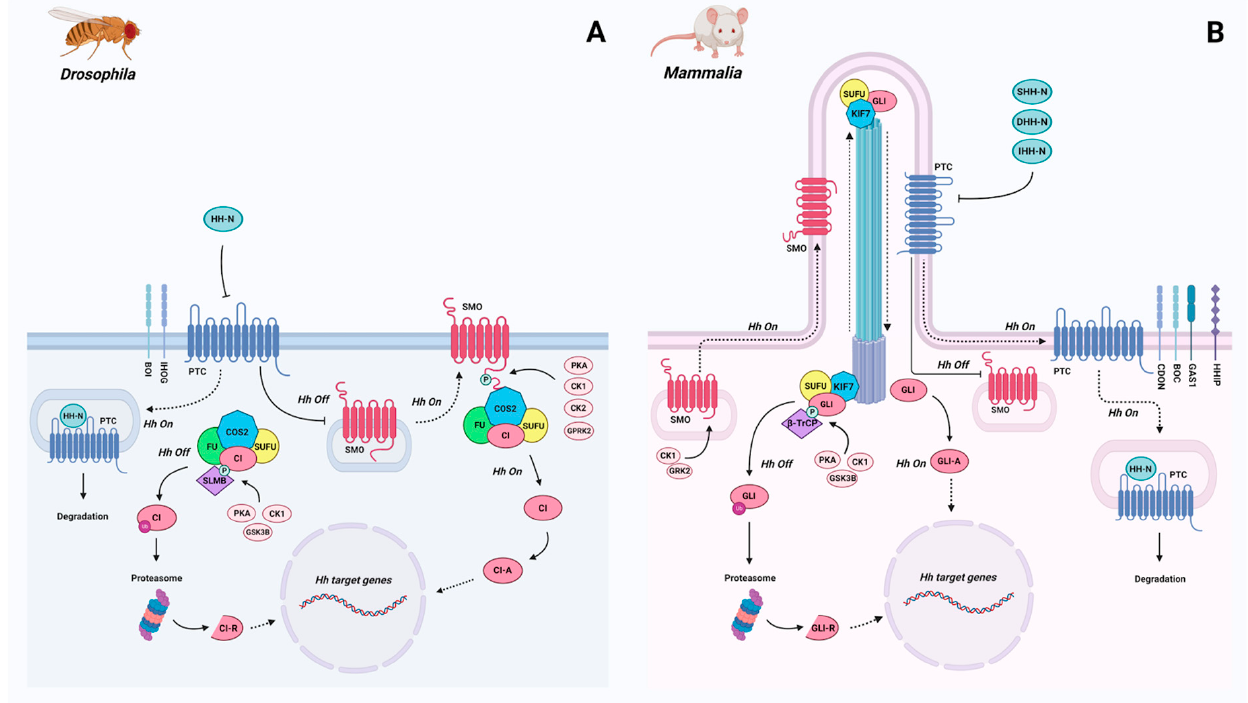
Figure 1. The scheme of the Hedgehog pathway in Drosophila ( A ) and mammals ( B ). Hh Off, absence of the ligand; Hh On, presence of the ligand. The dashed lines show the movement of signaling components inside the cell. Arrows indicate the protein interactions and modifications. The Hh ligand is secreted by Hh-producing cells with the help of Disp and interacts with the Ptc receptor on recipient cells. This interaction leads to the removal of the inhibition effect from the other receptor Smo. Active Smo provides signal transduction inside the cell, preventing the cleavage of the transcription factor Gli/Ci. Full-sized Gli/Ci goes to the nucleus and acts as a gene activator [1,12–14]. For details, see the Results section.